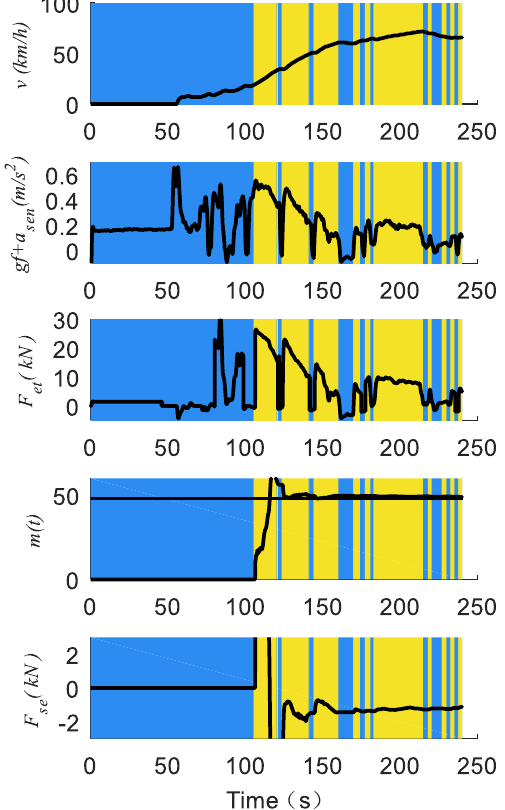
Figure 4. One set of the full-load test.